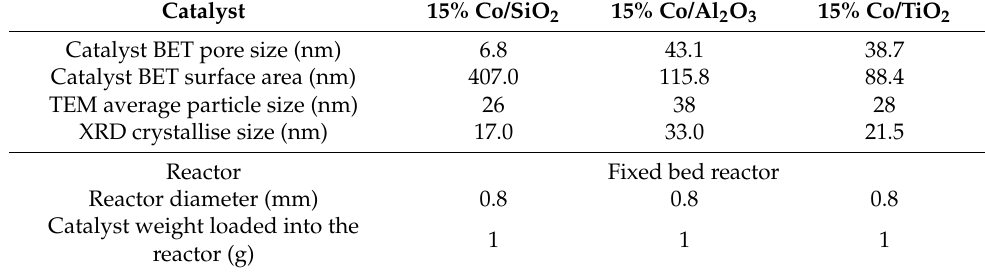
Table 1. Physical properties of the catalysts and reactor used in this work.